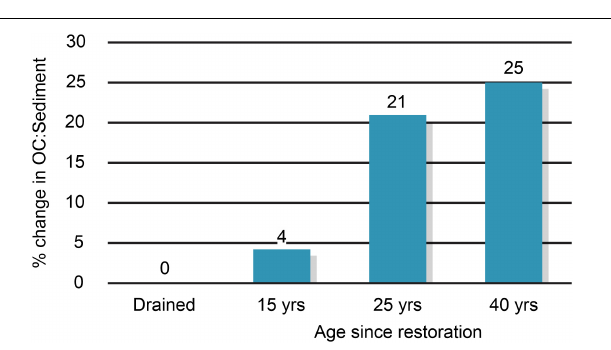
FIGURE 5 | Percent change in the ratio of OC to sediment stocks for drained sites and restored wetlands after 15, 25, and 40 years.